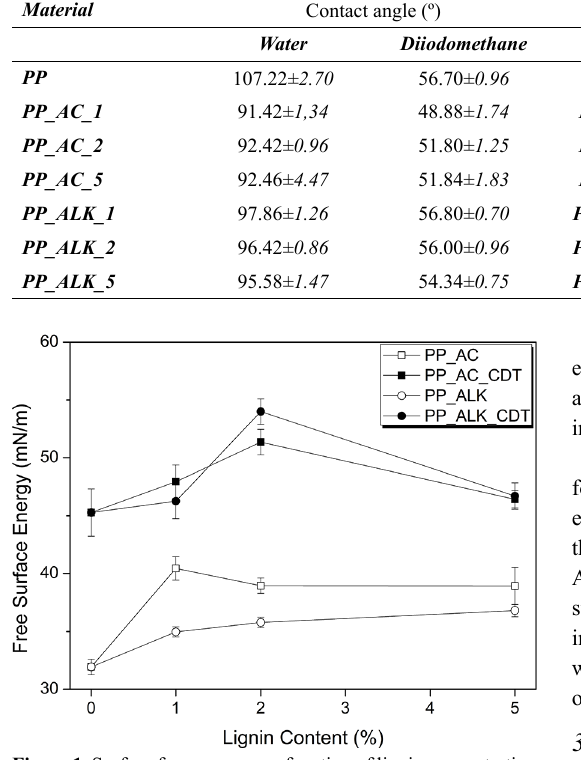
Figure 1. Surface free energy as a function of lignin concentration (AC and ALK) with and without surface